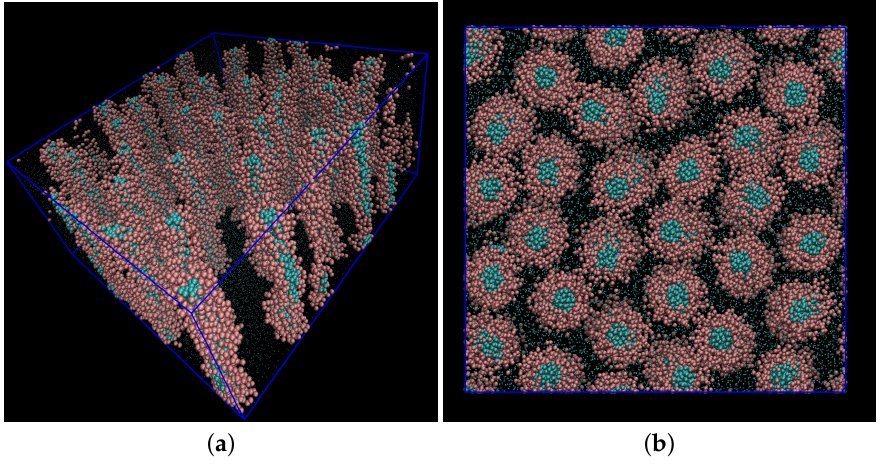
Figure 10. ( a ) Snapshot from the N phase composed of 900 TP6EO2M molecules simulated at a coarse-grained level using the Martini 3 model from reference [113] (54,909 Martini water sites representing 219,636 water molecules). The snapshot shows short chromonic stacks that are joined across the periodic boundary conditions. Small blue dots between columns represent Martini water sites. ( b ) Snapshot from the M phase of TP6EO2M showing the hexagonal packing of columns in this phase (9266 Martini water sites).